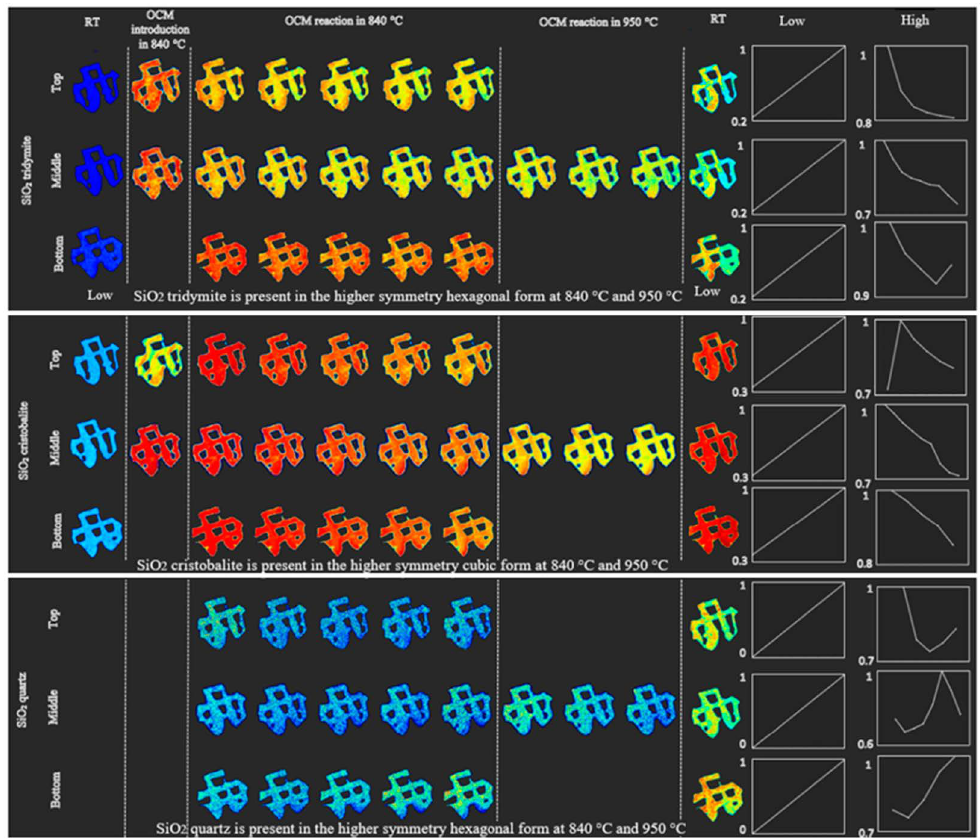
Figure 7. Reconstructed 2D images of the distribution of the catalyst silica support indicate macro and micro-scale features in space (at three positions, top, middle and bottom of the monolith) as a function of time and temperature during OCM introduction and under OCM operating conditions at 840 ◦ C for a duration of 5.5 h and at 950 ◦ C for a duration of ca 1 h; the thermal color maps show the following distribution of crystalline phases of the silica support: tridymite ( top panel ), cristobalite ( middle panel ), quartz ( bottom panel ); tridymite and quartz are present in their higher symmetry hexagonal forms at 840 and 950 ◦ C; quartz started to form at high temperature; cristobalite is present in the higher symmetry cubic form at 840 and 950 ◦ C. Panels present the phase distribution normalized in respect to maximum value of scale factor for particular silica phase in each separate z positions—in this way it is possible to observe the phase distribution as a function of time and conditions. In addition, the plots on the right present the mean value for normalized scale factor and for each XRD-CT